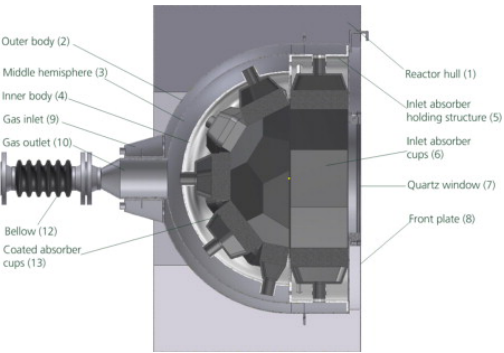
Figure 10. Sectional view of the spherical cavity reactor proposed by Houaijia et al. Reprinted from [4] with permission from Elsevier.